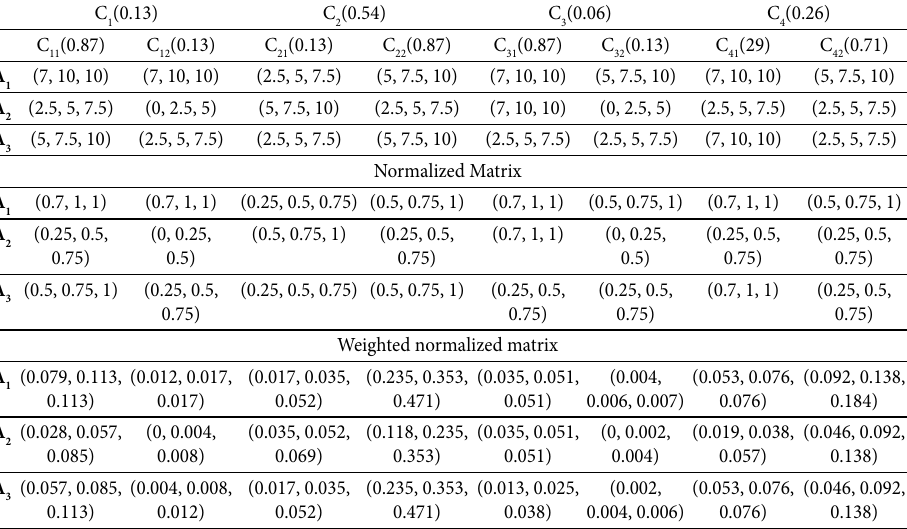
Table 8. Normalized and weighted matrix